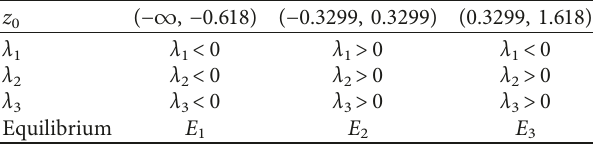
Table 2: The eigenvalues as ( z 2